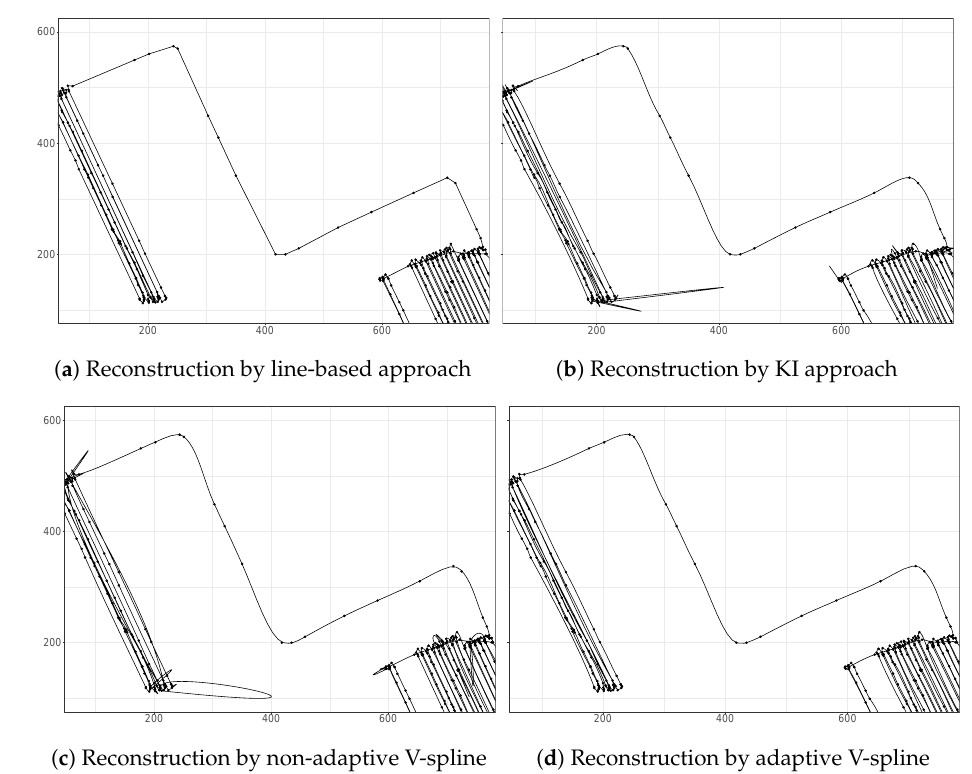
Figure 4. A comparison of the reconstructions by a line-based approach, kinematic interpolation, non-adaptive V-spline, and adaptive V-spline. KI relies on misleading velocity information that generates unrealistic trajectories. The non-adaptive V-spline also generates unrealistic trajectories at sharp-turning and braking points. However, the adaptive V-spline adapts to the information based on observed velocity discrepancy and generates plausible